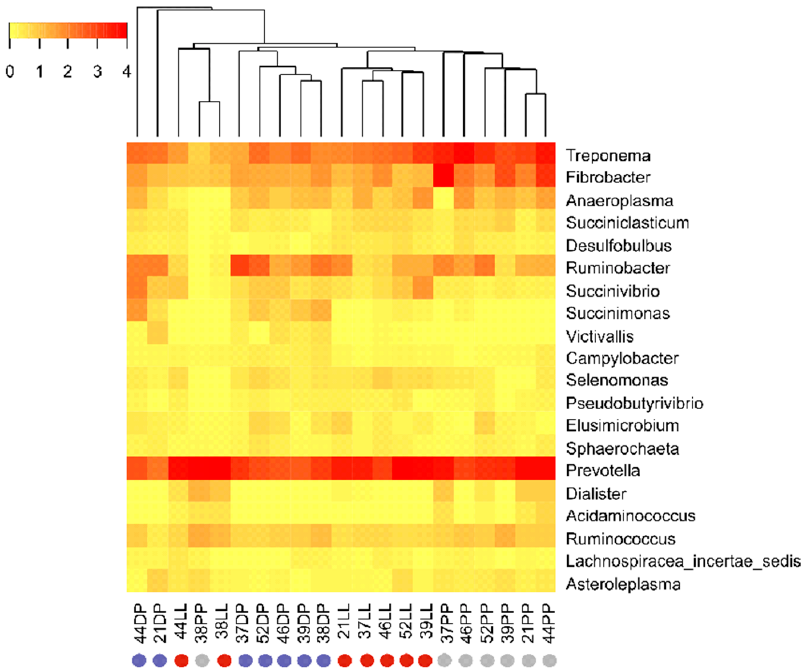
Figure 3. Heatmap at genus-level of active rumen bacterial communities of different physiological stages. The twenty most abundant bacterial genera (excluding the unclassified bacteria) during LL, DP, and PP were included in the heatmap.